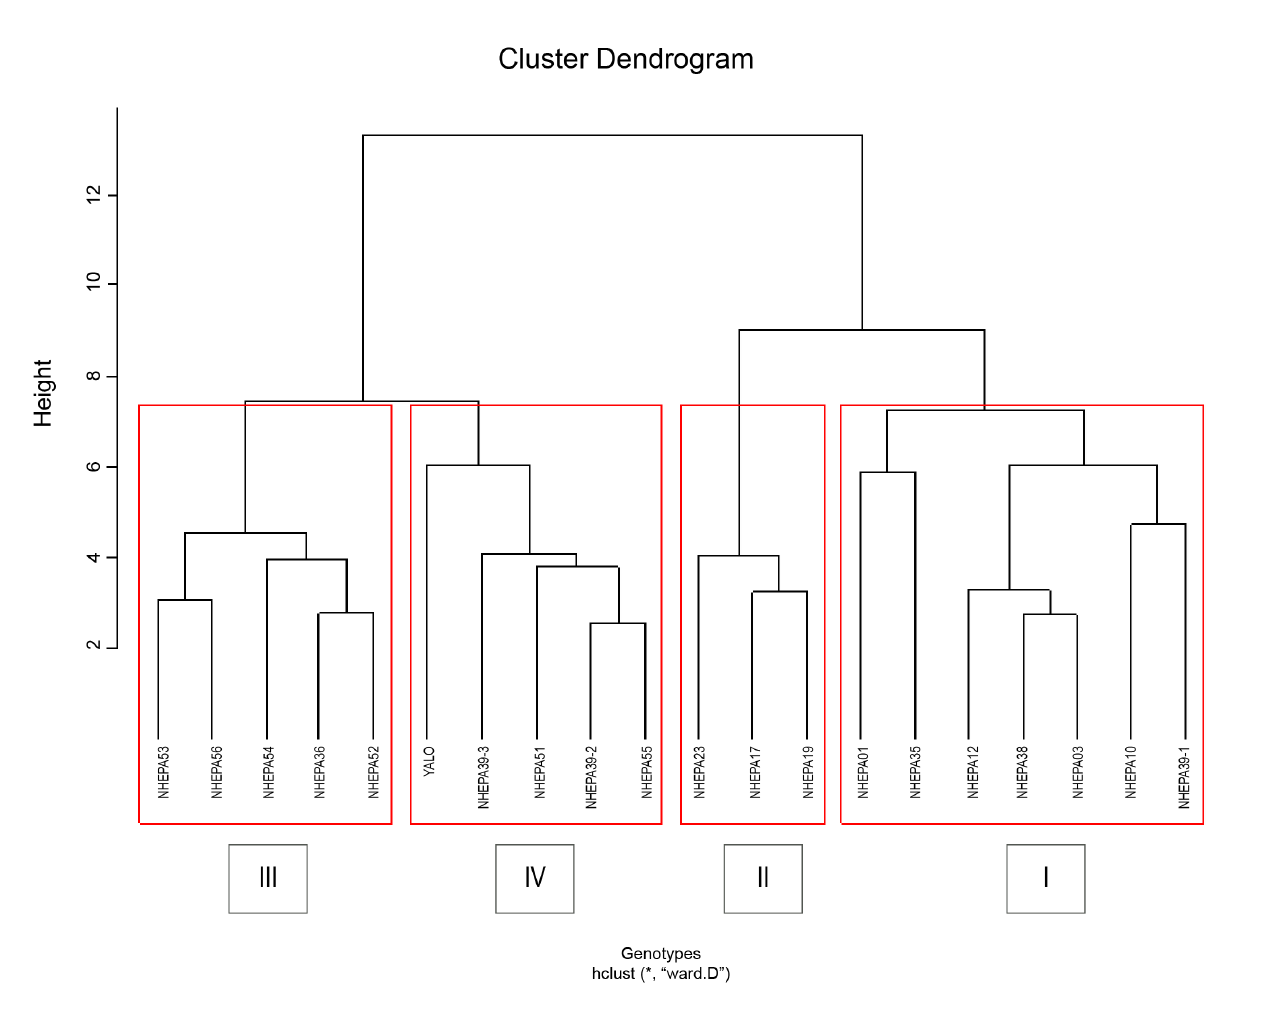
Figure 3. Cluster dendrogram showing the relationships among the 20 eggplant accessions with cluster tree cut value at 7.3.